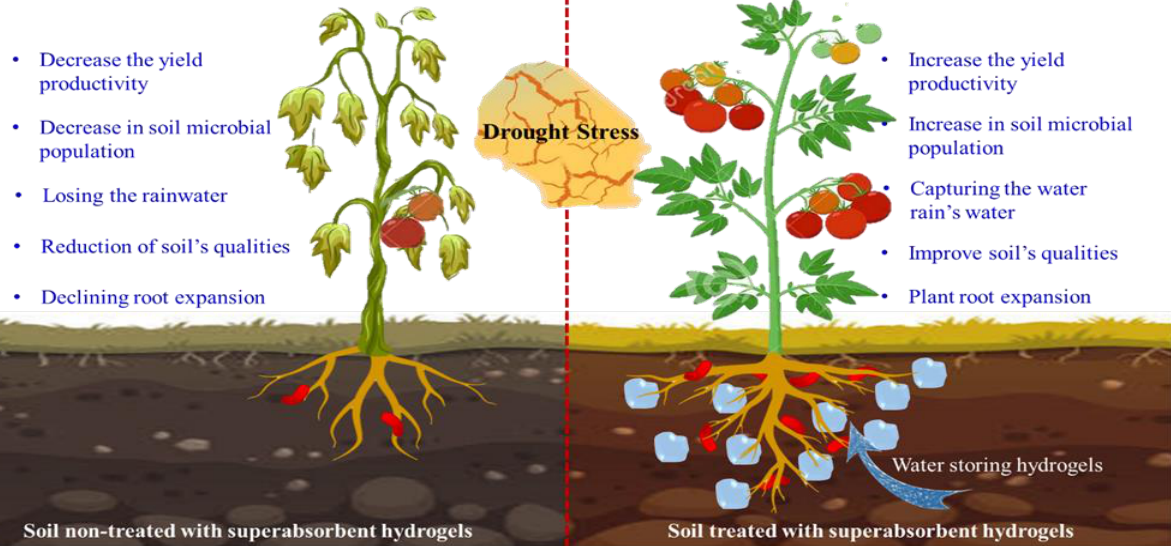
Figure 7. The advantages of using superabsorbent hydrogels (SAHs) for water holding in agriculture.